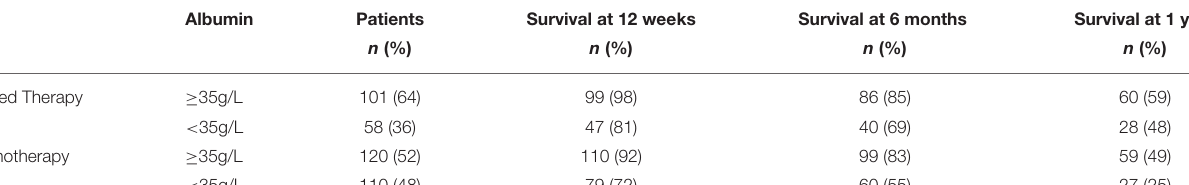
TABLE 2 | The relationship between pre-treatment albumin and overall survival at 12 weeks, 6 months and 1 year in patients with NSCLC treated with first-line targeted therapy or immunotherapy-based therapy. Albumin Patients